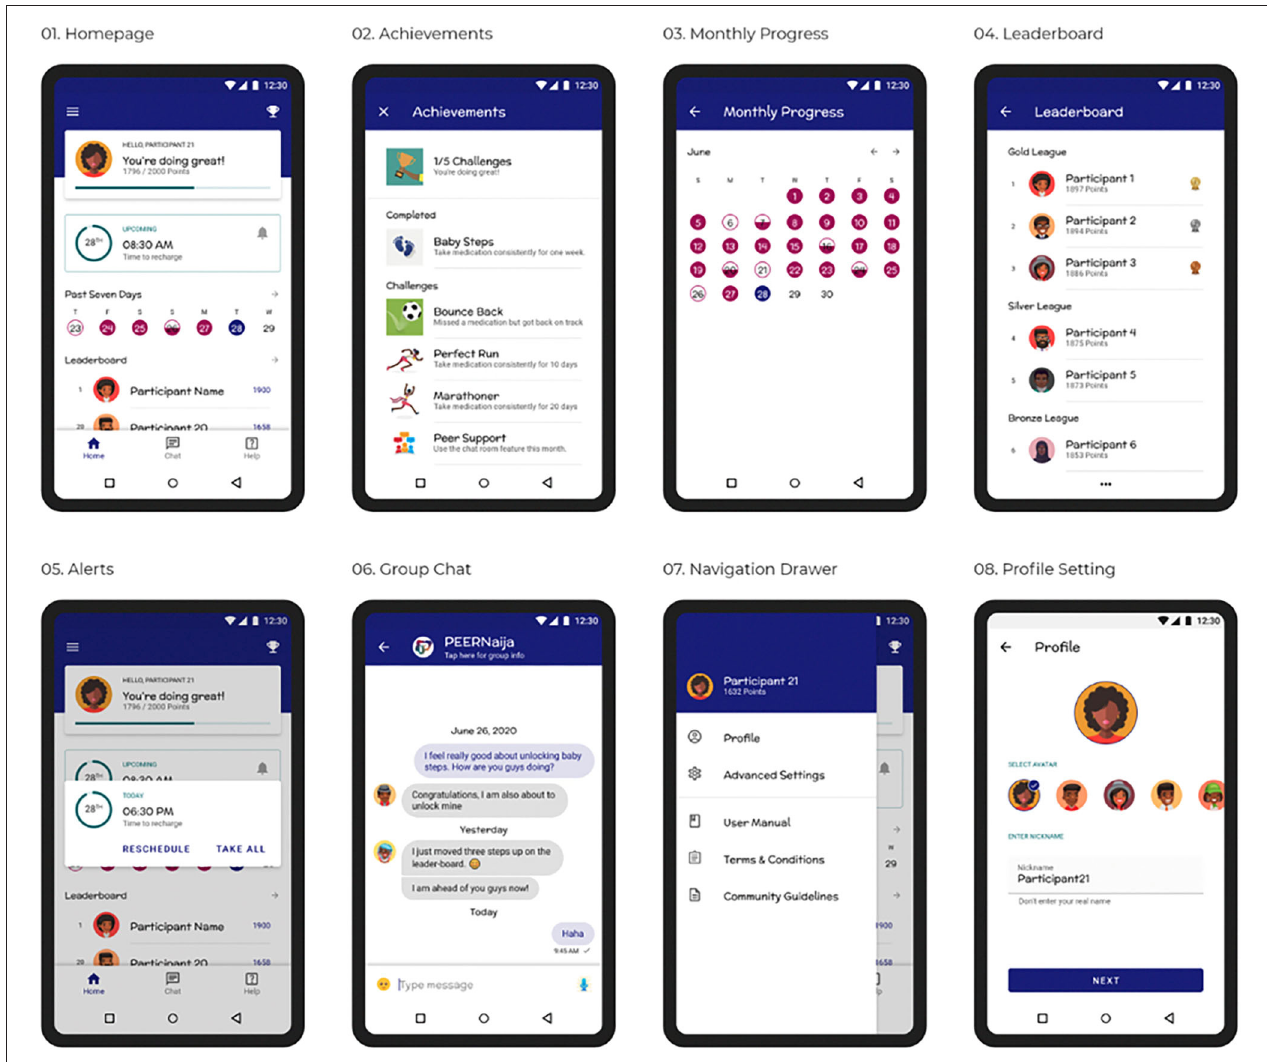
FIGURE 3 | (3.1–3.8) PEERNaija application user